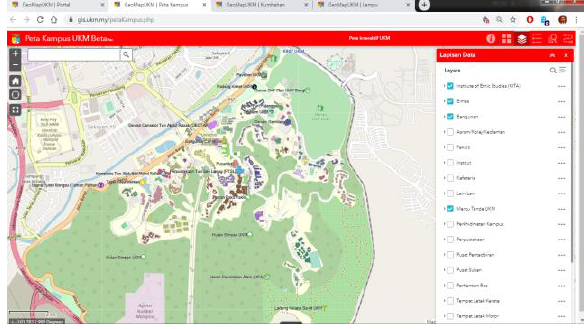
Figure 7. An example of an online UKM campus